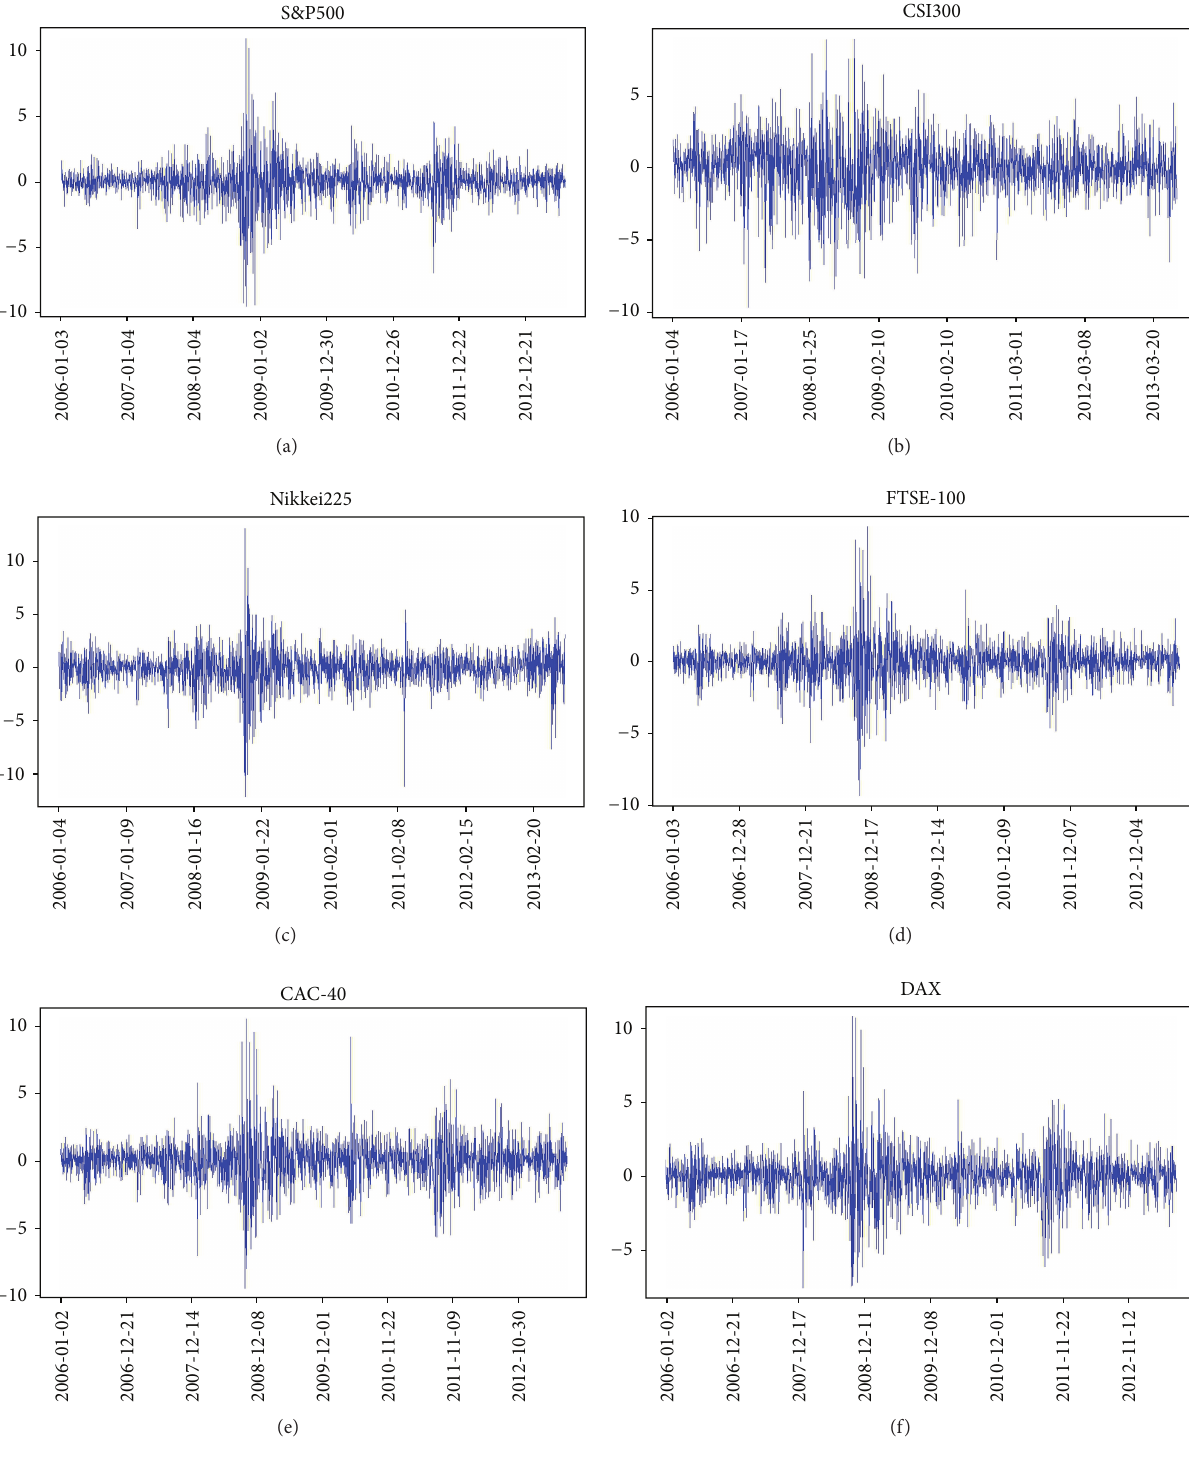
Figure 1: Daily returns of S&P500 (US), CSI300 (China), Nikkei225 (Japan), FTSE-100 (UK), CAC-40 (France), and DAX (Germany). Notes: daily data from January 2006 to July